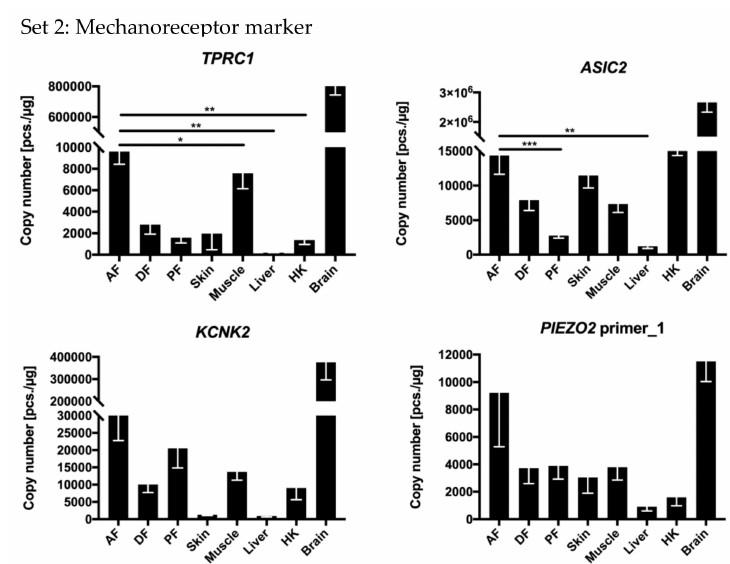
Figure 3. Expression levels of selected mechanoreceptor marker genes from Set 2 across tissues. The expression levels are given as absolute copy numbers (per 1 µ g RNA) normalized against three reference genes. Statistically significant deviations are indicated only between AF and the other tissues. Expression values determined in brain were excluded from the statistical evaluation. Significance levels are indicated by * p ≤ 0.05, ** p ≤ 0.01, *** p ≤ 0.001. Error bars indicate the SEM. The presentation